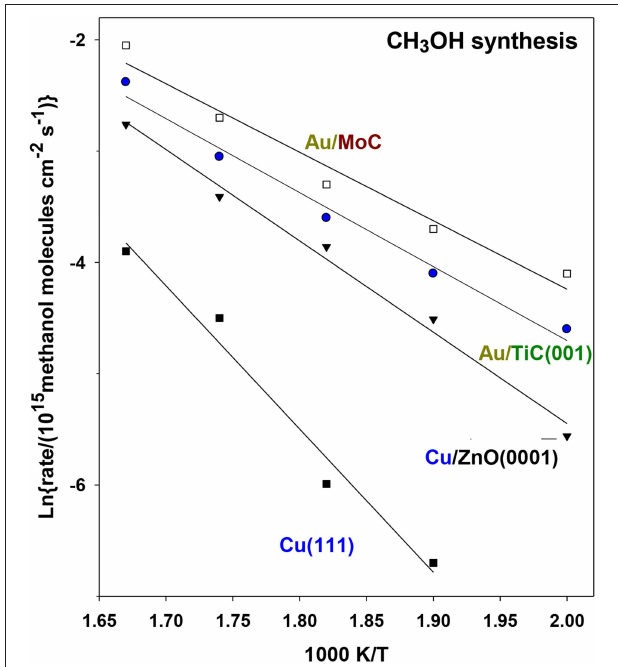
FIGURE 13 | Arrhenius plots for the generation of CH 3 OH through CO 2 hydrogenation on a several Au-containing catalysts. Initially, 0.2ML of gold were deposited on MoC and TiC(001). In a batch reactor, both catalysts were exposed to 0.049 MPa (0.5 atm) of CO 2 and 0.441 MPa (4.5 atm) of H 2 at temperatures of 600, 575, 550, 525, and 500K. Reproduced with permission from Posada-Pérez et al. (2016), copyright 2016 by the American Chemical Society. TABLE 1 | Apparent activation energies for CO 2 hydrogenation on a series of (in kcal/mol) a . Catalyst CO, RWGS CH 3 OH synthesis